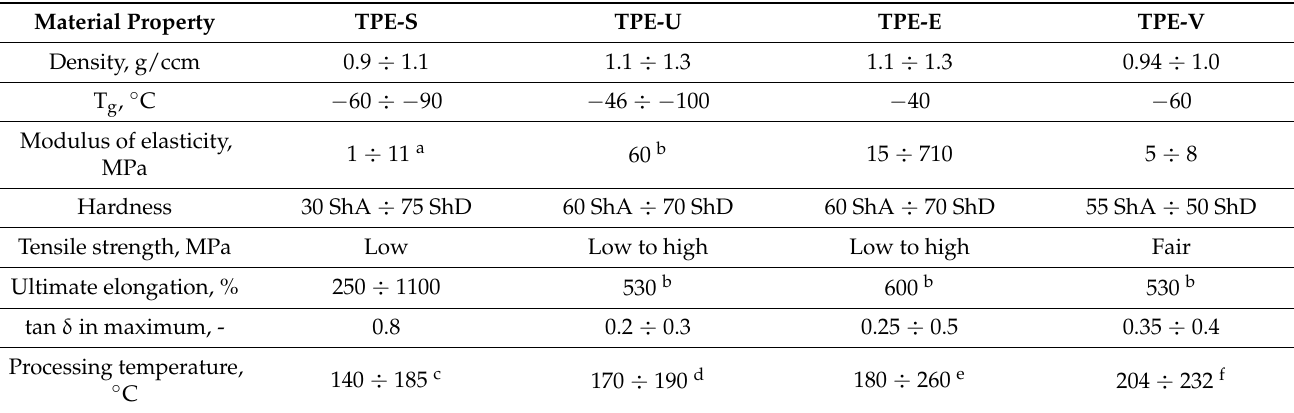
Table 2. Basic thermoplastic elastomers and their physical properties according to [40] (pp. 161–164, 170, 174, 215–220, 254, 329), [68,73,74].